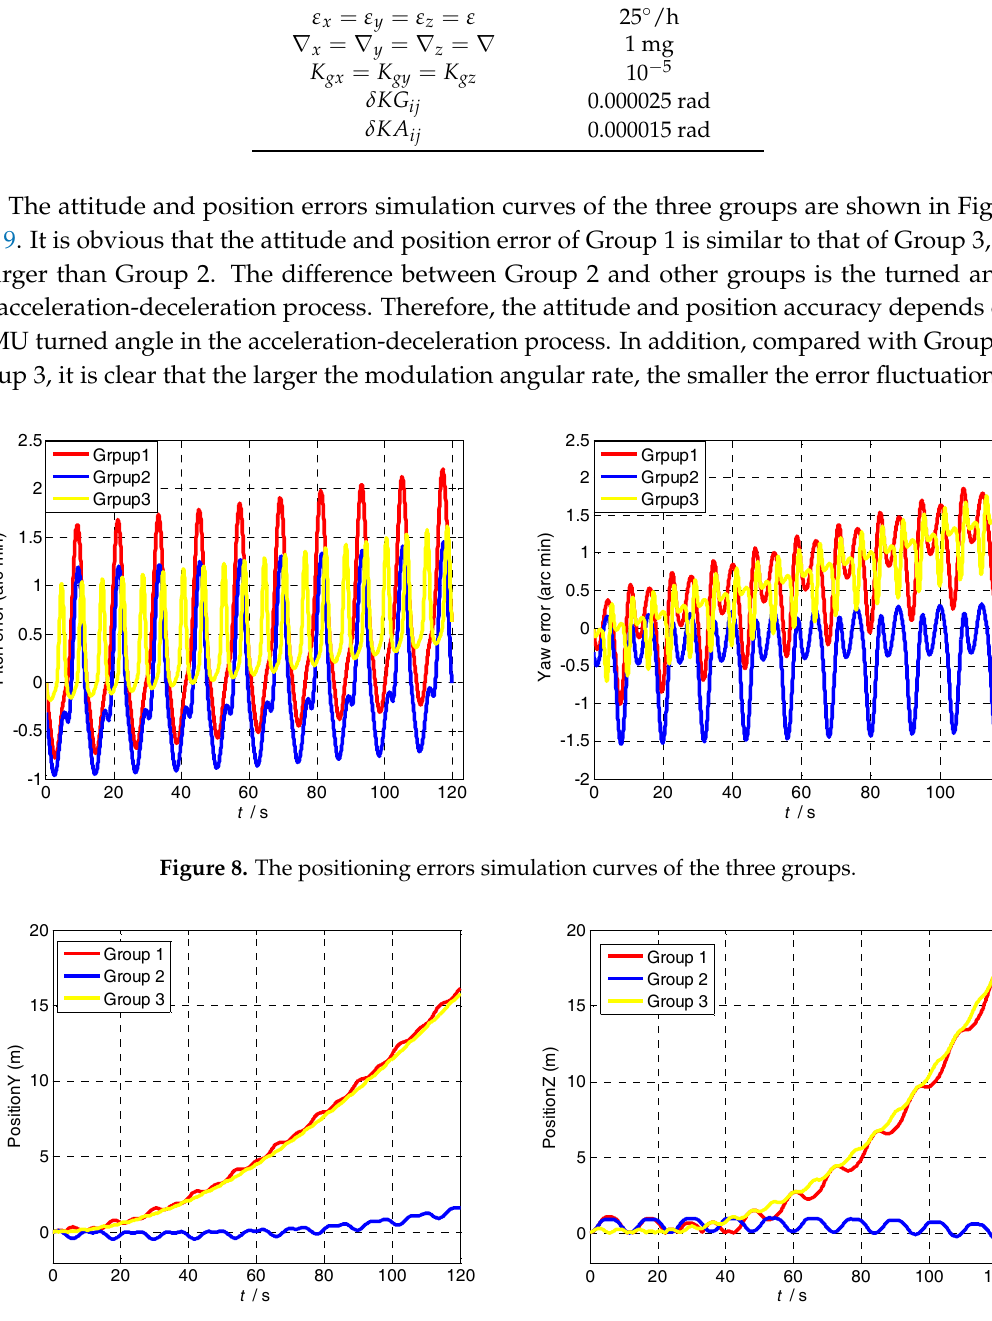
Figure 9. The positioning errors simulation curves of the three groups.